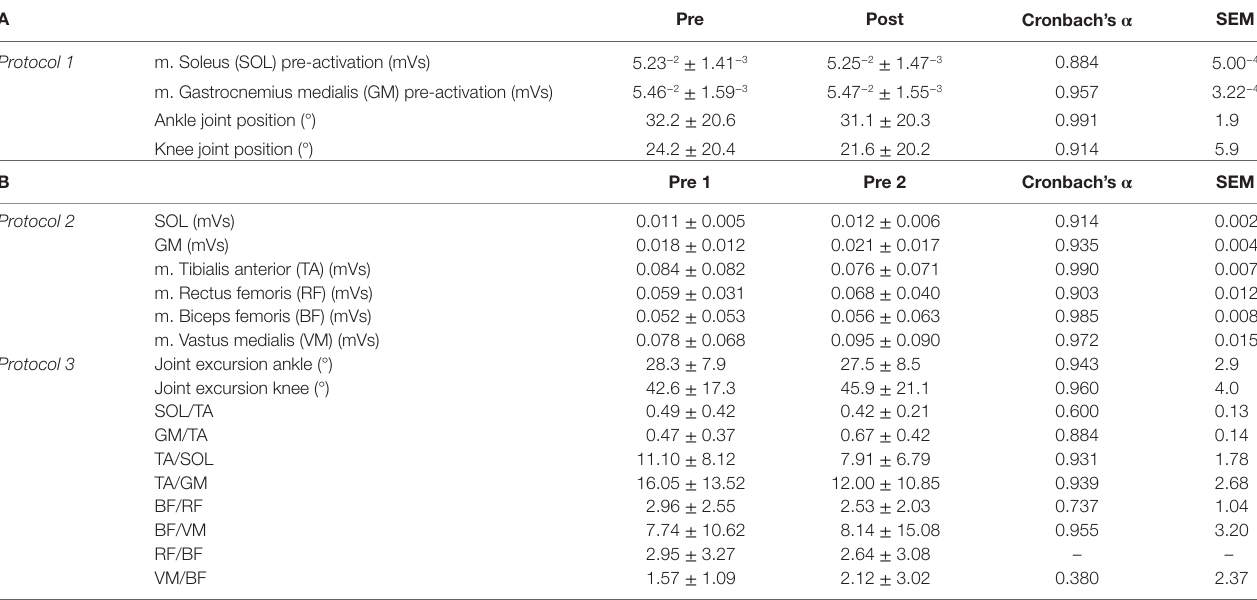
TaBle 2 | Absolute [standard error of measurement (SEM)] and relative test–retest reliability (Cronbach’s α ) was evaluated with the initial position from pre- to post-WBV ( Protocol 1 , A) and between both pre-measurements ( Protocol 2 and 3 , B).